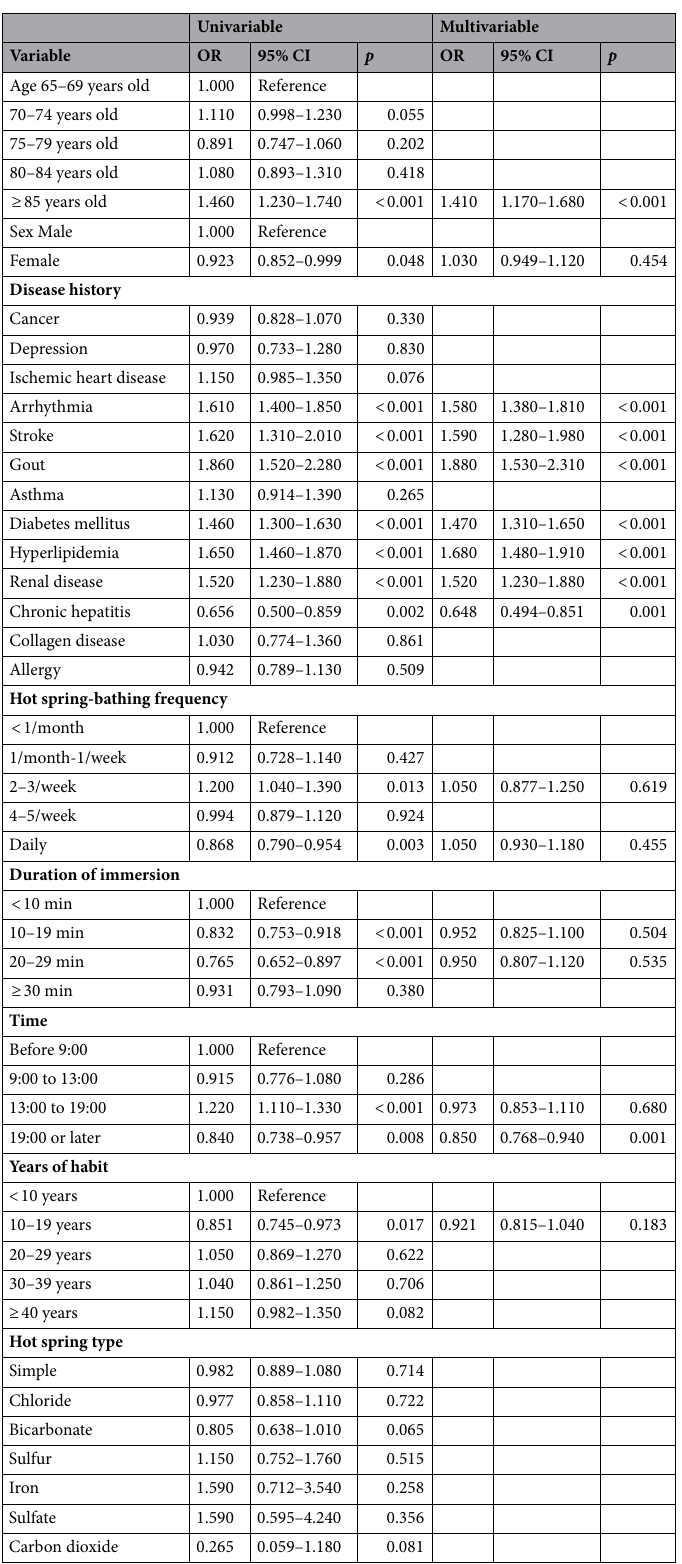
Table 2. Univariable and multivariable analysis of variables influencing history of hypertension. OR odds ratio; CI confidence interval. † Univariable or multivariable competing event statistics analyzed using a logistic regression model were applied to a positive history of hypertension. Covariates significant at p < 0.05 in univariate analysis were included in the multivariate